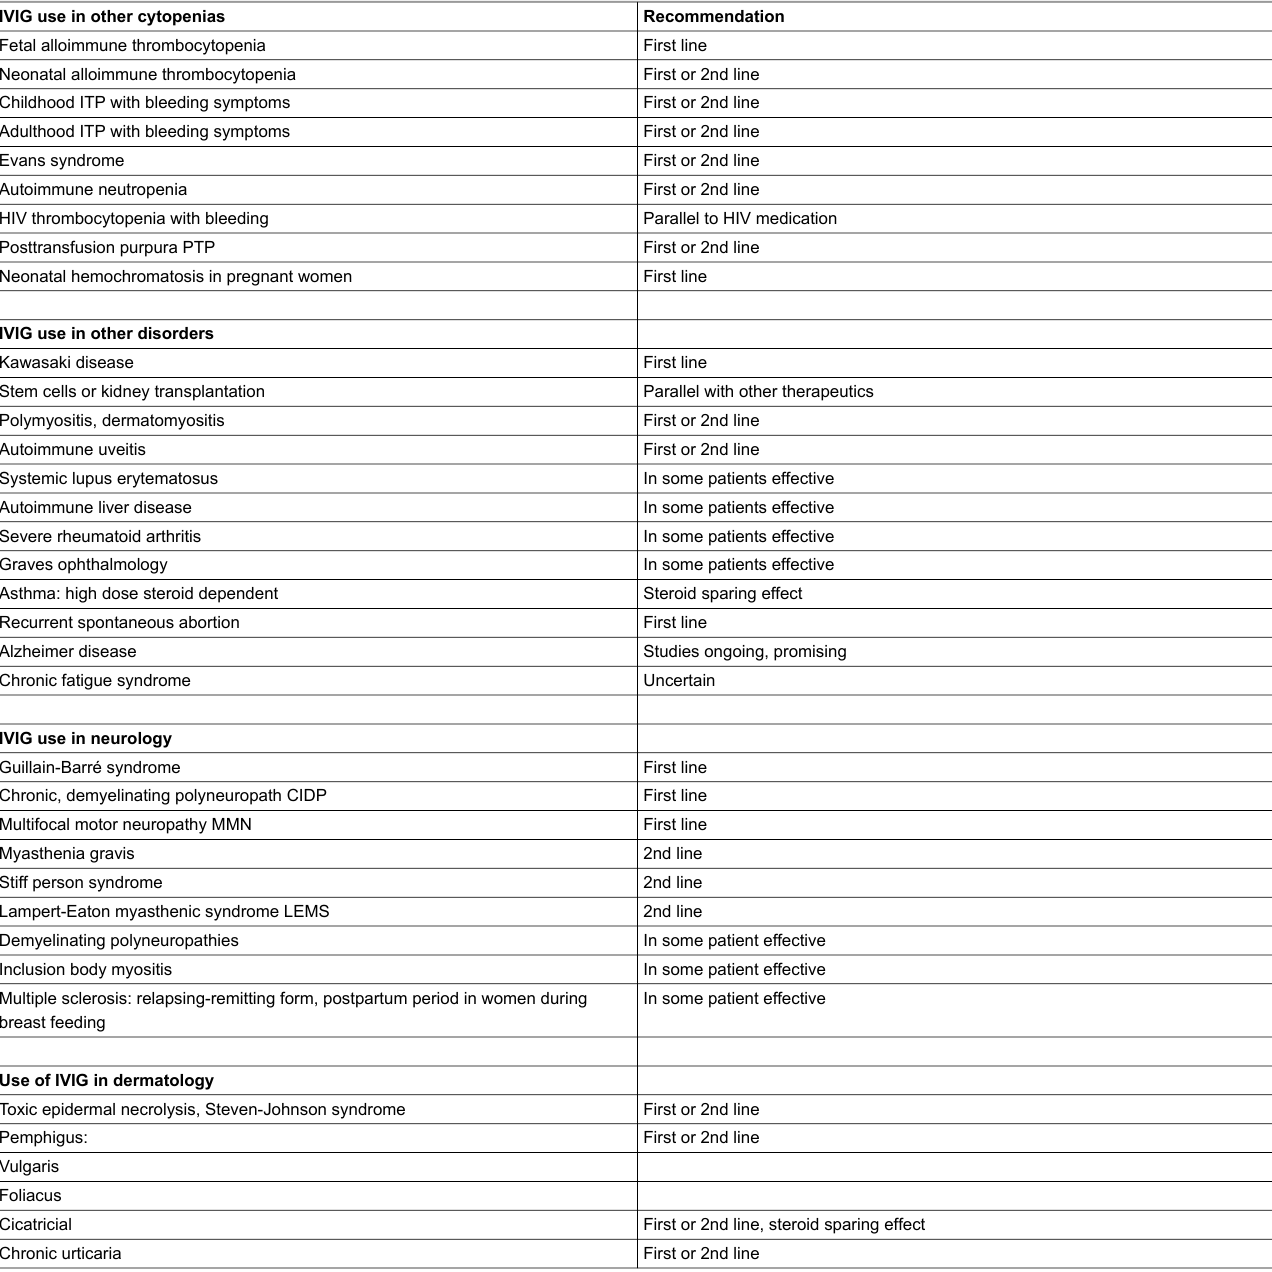
Table 1: IVIG use in other cytopenias, other inflammatory or autoimmune disorders, in neurologic and dermatologic, inflammatory and autoimmune disorders. Recommendations according to the various guidelines [59]. IVIG use in other